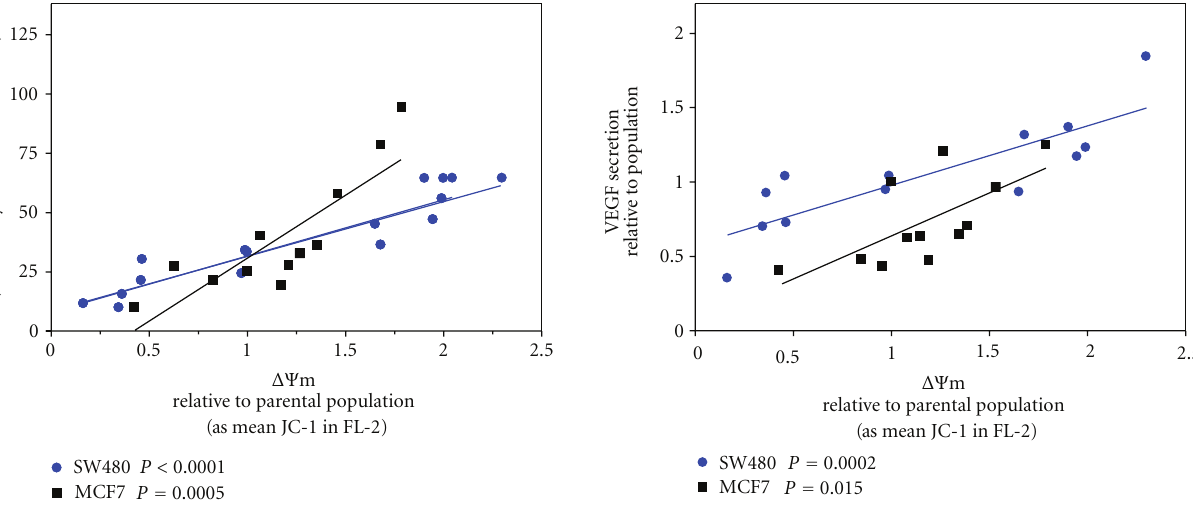
Figure 3: Di ff erences in the Intrinsic ΔΨ m of subcloned cell lines derived from primary colon and mammary tumors and from a metastatic colon tumor are linked to sensitivity to the chemoprotec- tive agent sodium butyrate (NaB). The SW480 and MCF7 cell lines, and subclones derived from each of the cell lines, were exposed to 5mm NaB for 72 hours. Viability was determined by MTT assay, expressed relative to untreated cells, and plotted as a function of relative ΔΨ m.